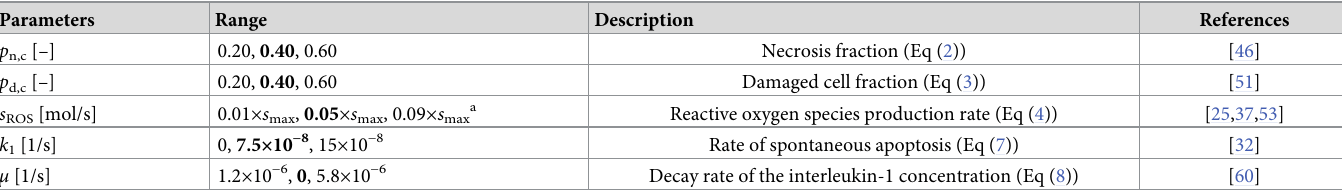
Table 1. Parameters for the sensitivity